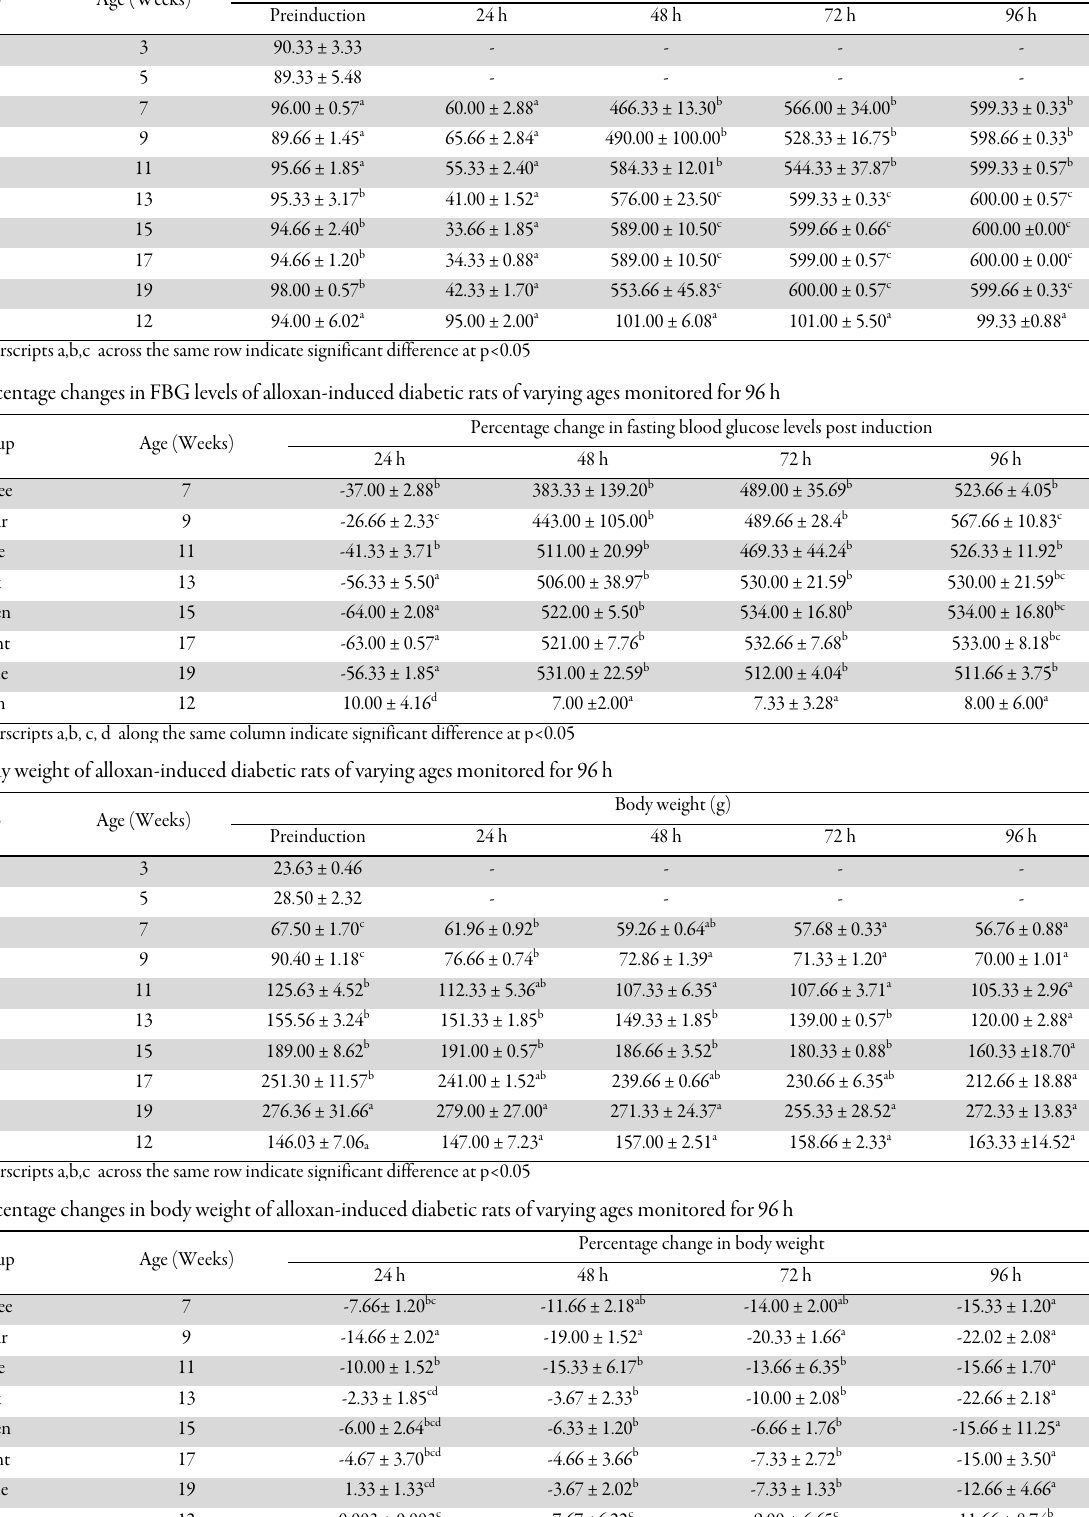
Table 1. Fasting blood glucose (FBG) levels of alloxan-induced diabetic rats of varying ages monitored for 96 h Group Age (Weeks)